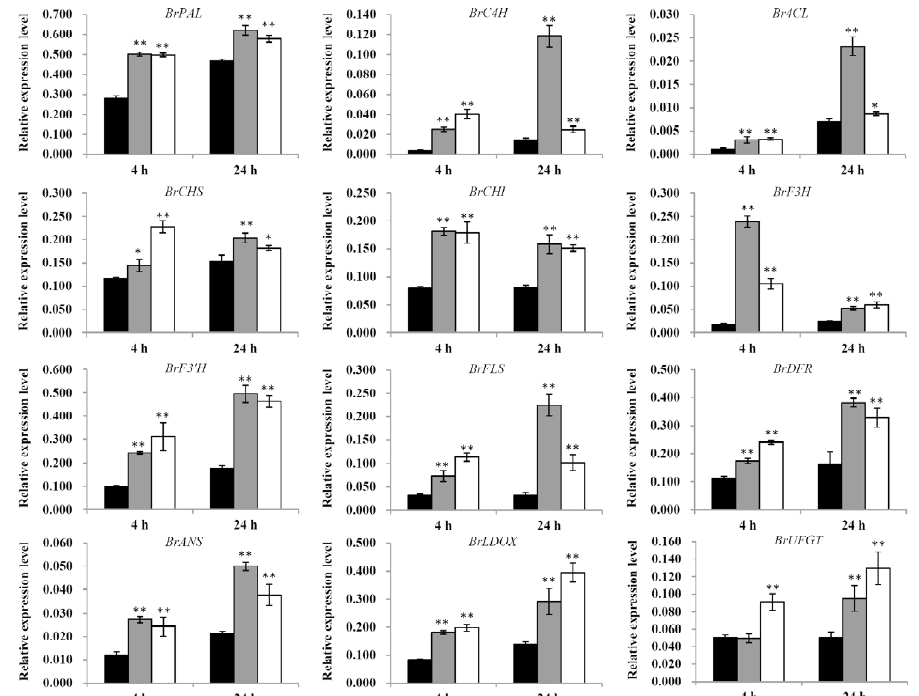
Figure 7. Relative expression levels of the genes related to flavonoid biosynthesis in response to UV-B radiation. Black columns represent control; gray columns represent 2 µmol·m − 2 ·s − 1 UV-B; white columns represent 4 µmol·m − 2 ·s − 1 UV-B. Gene expression values are relative to reference BrActin2 expression; data points represent the mean ± SE of three biological replicates. Asterisks indicate a significant difference (* p < 0.05; ** p < 0.01) relative to the corresponding control using Student’s t -test.